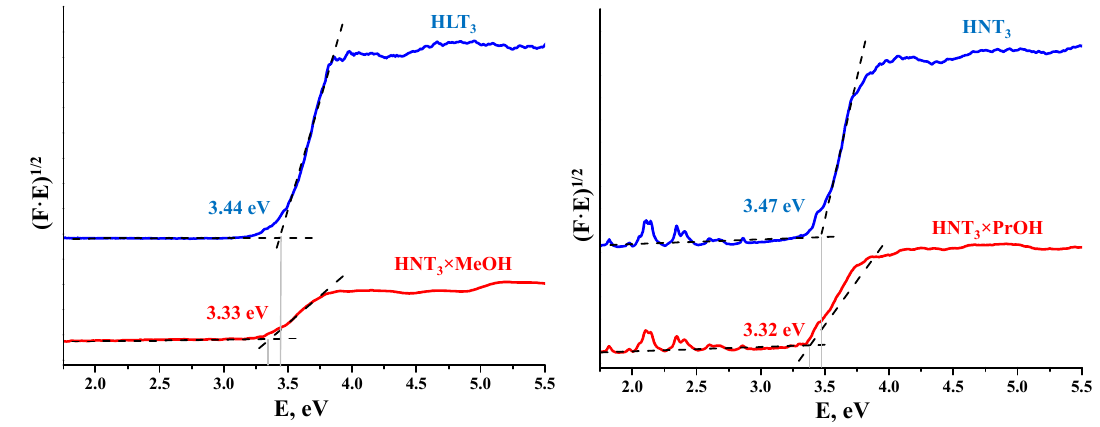
Figure 5. Tauc plots for the protonated titanates and some inorganic-organic derivatives. Table 3. Light absorption characteristics and specific surface area of the samples.